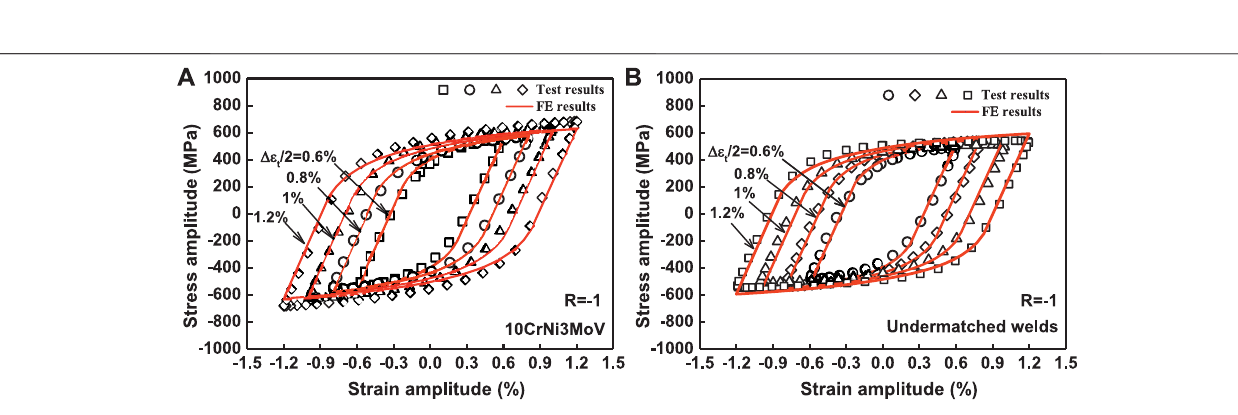
Figure 10B is the evolution of Δ w 0 with per cycle under 0.8% strain amplitudes for the base metal. It can be seen that the values of Δ w 0 in different stages are higher than the results of 0.6% strain